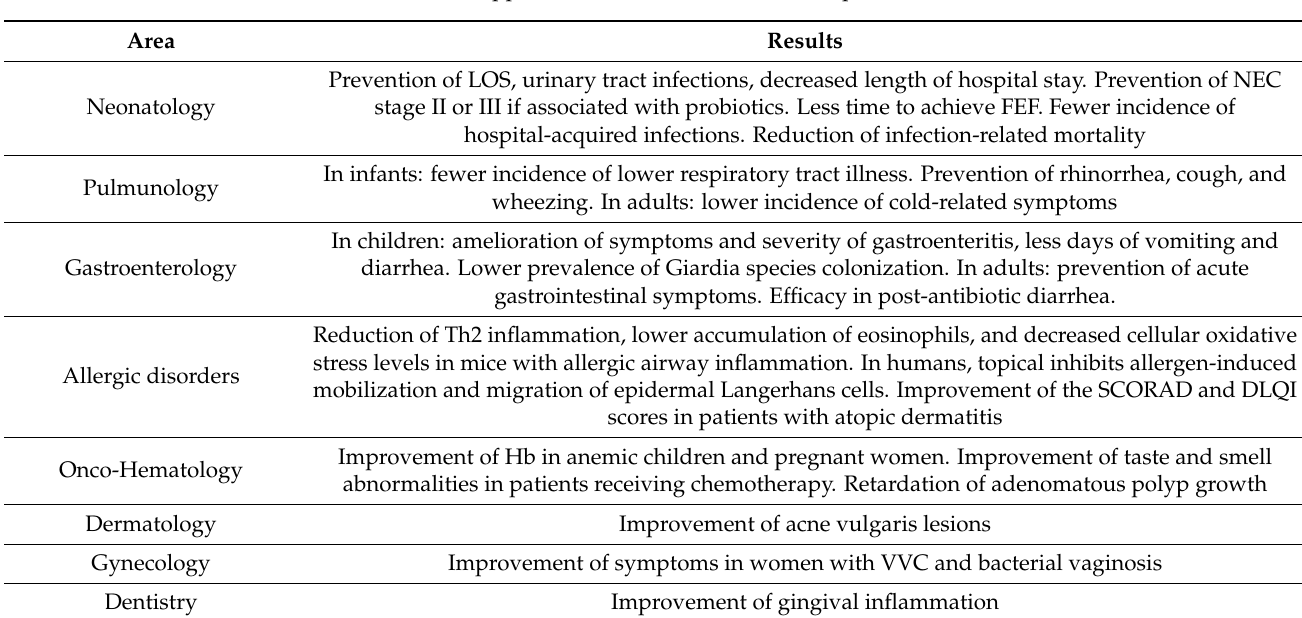
Table 1. Applications of lactoferrin in clinical